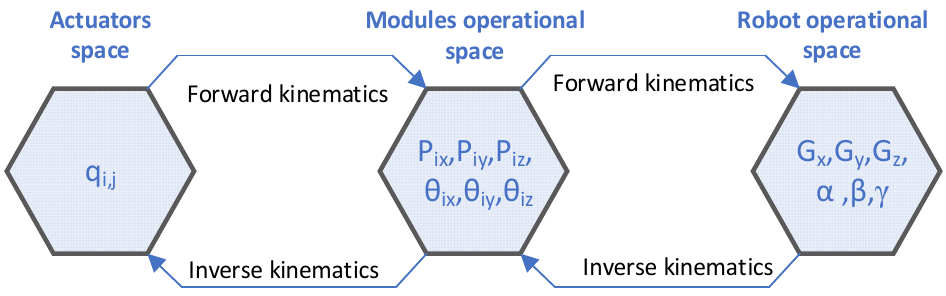
Figure 1. Python Robot ( a ) CAD Model with n = 10 modules ( b ) kinematic diagram of one module.